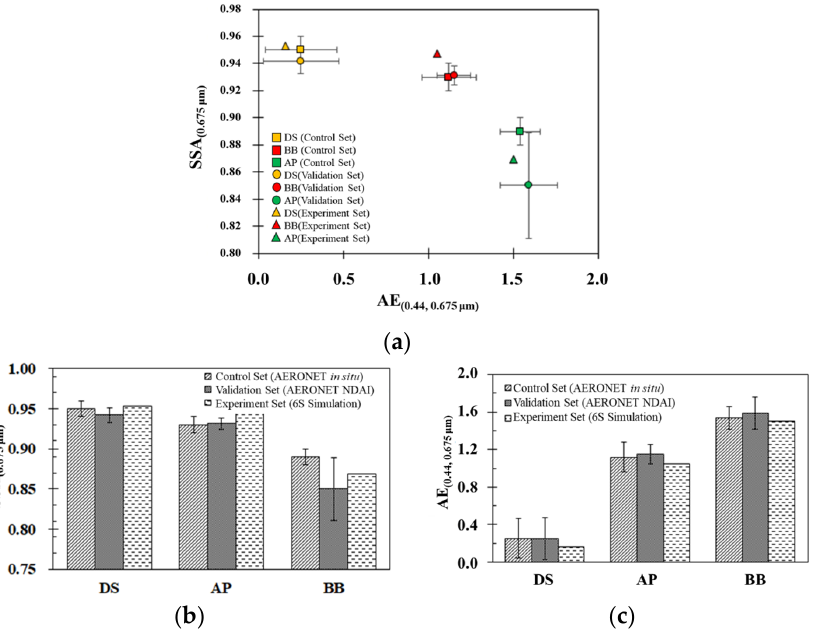
Figure 9. ( a ) Comparisons of SSA (0.675 μ m) and AE (0.44, 0.675 μ m) for DS (yellow), BB (green) and AP (red) aerosol types between the results of the validation dataset from the NDAI approach (circle) and the control dataset (square) in Table 2 and 6S model simulations (triangle). The detailed comparisons are shown in a bar chart format for the validation dataset from the NDAI approach (dense–dot) and the control dataset (slashed) and 6S model simulations (dashed) in ( b ) SSA (0.675 μ m) and ( c ) AE (0.44, 0.675 μ m) , respectively.